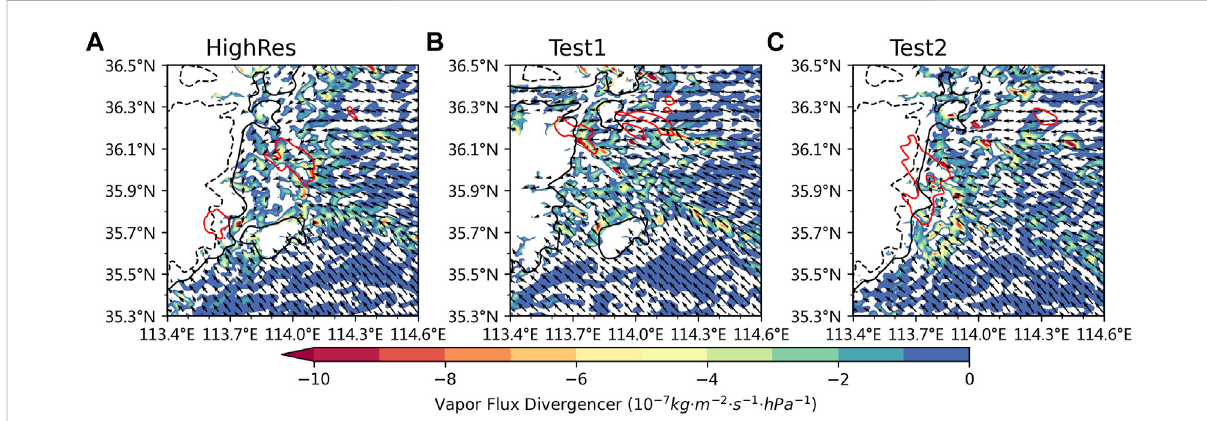
FIGURE 8 Simulated wind fi eld at 925 hPa at 0800 UTC on July 19 and precipitation (red line) exceeding 50 mm/h (0800 – 0900 UTC on July 19) by HighRes terrain (A) , Test1 (B) and Test2 (C) . The black solid line denotes the 500 m contour line, and the black dotted line denotes the 1000 m contour line. The shaded area indicates the vapor fl ux divergence (units: 10 − 7 · kg · m − 2 · s − 1 · hPa − 1 ).